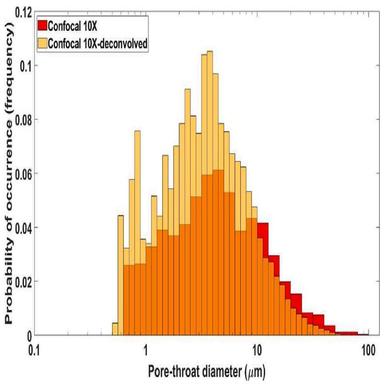
Probability distributions of the pore-throats obtained from the pore network model of the 3D confocal stack images, presented in We can clearly identify the bimodal pore throat size of the deconvolved image (orange color), unlike the original image, which demonstrates the capabilities of image deconvolution.